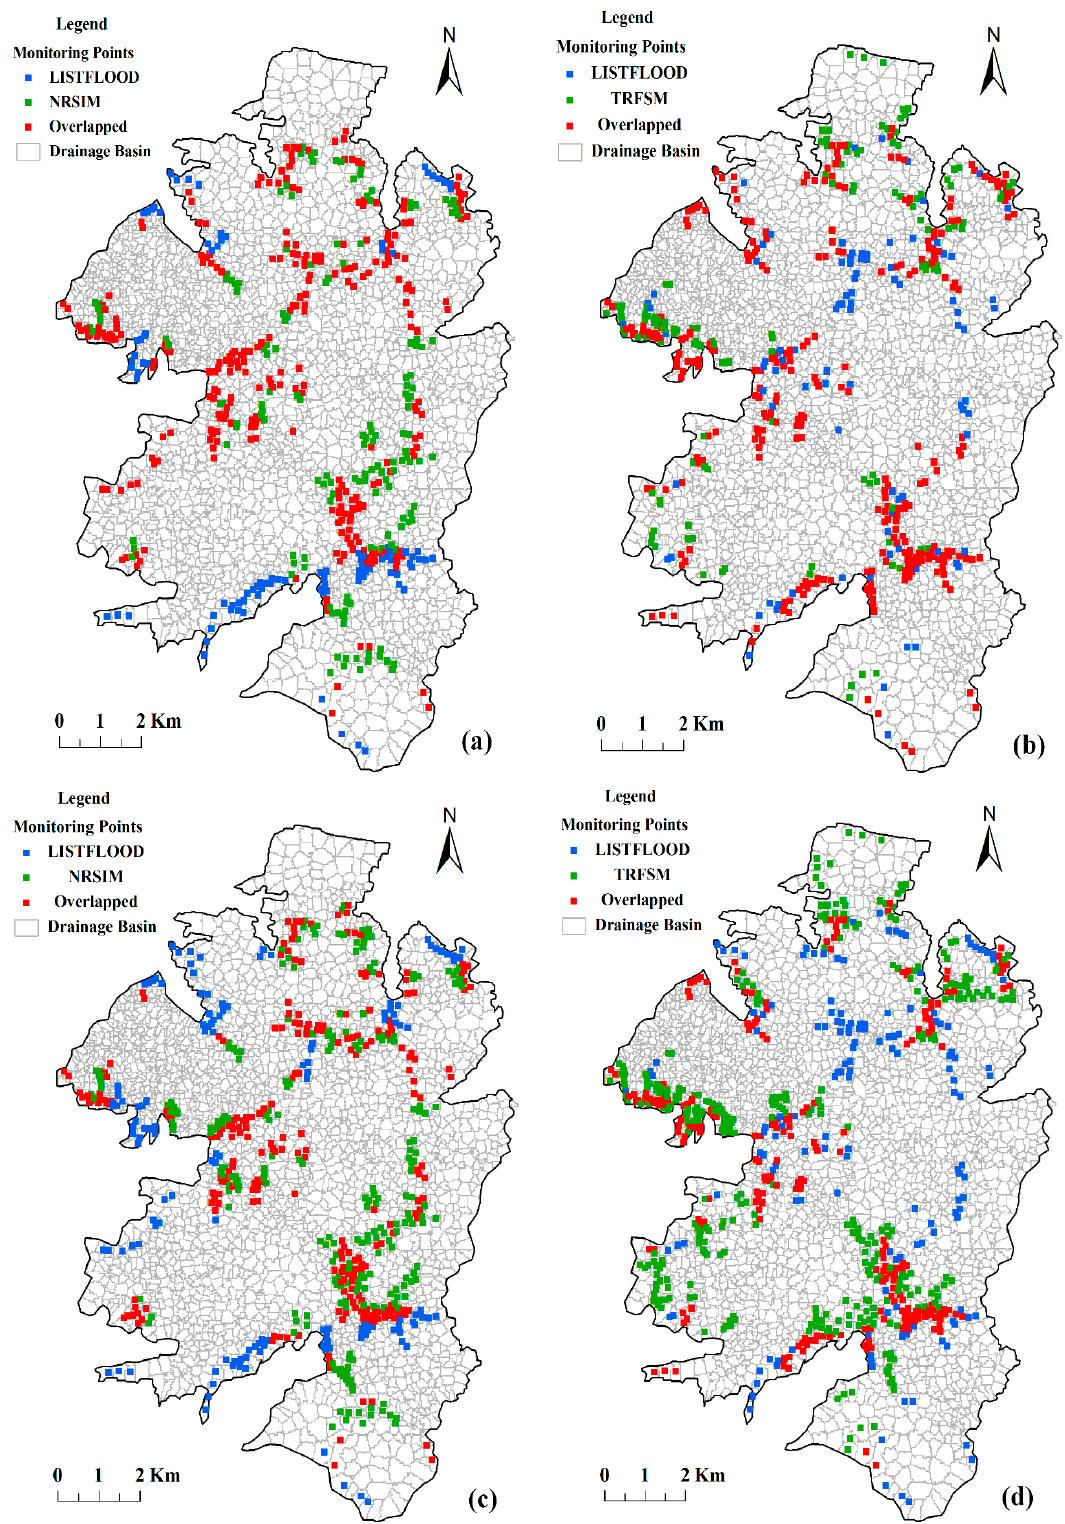
Figure 15. Comparison of inundation extents in a large-scale floodplain between LISFLOOD and: NRSIM ( a ); and TRFSM ( b ) using a 30-m resolution DEM. For a 90-m resolution DEM, the results for NRSIM and TRFSM are given in ( c , d ), respectively.